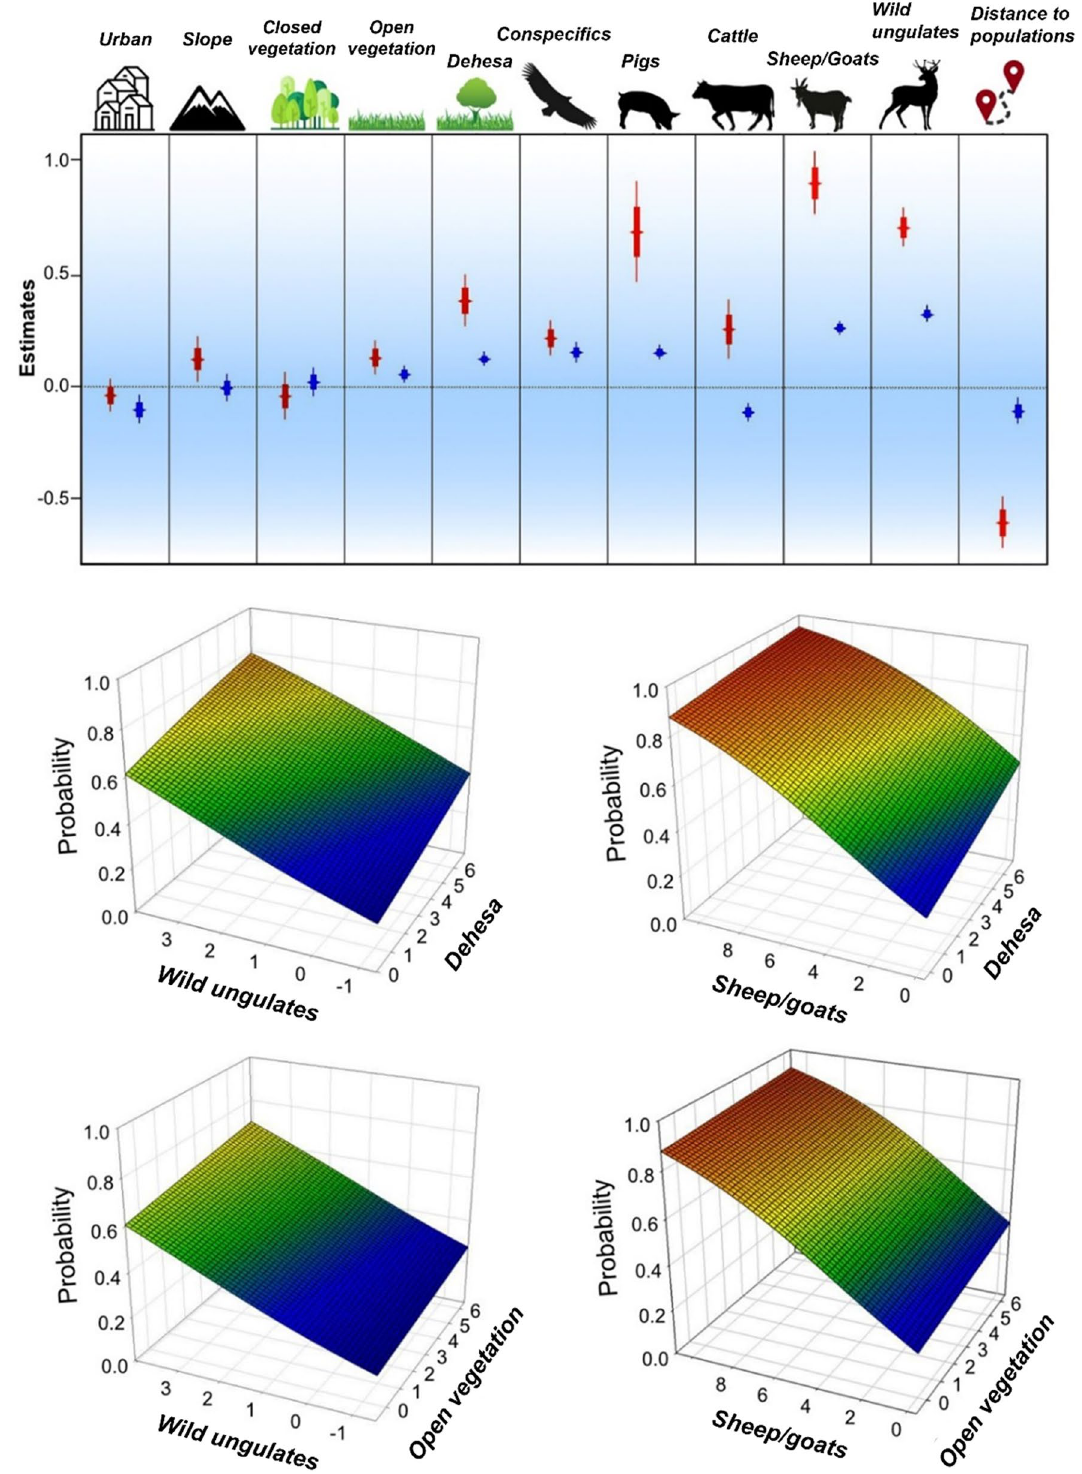
Figure 3. Coefficient plot for models evaluating spatial coincidence between populations. Thick and narrow bars represent respectively standard errors and confidence intervals (95%) of the estimates of variables within models evaluating the probability of presence of GPS-tagged Eurasian griffon vultures in a 10 × 10 km grid cell covering peninsular Spain (red) and the coincidence of vultures from different populations in the same grid cell (blue). Below we show the projection of the probability of coincidence in relation to the most relevant variables describing habitat ( Dehesa and Open vegetation ) and food resources ( Sheep/goats and Wild ungulates